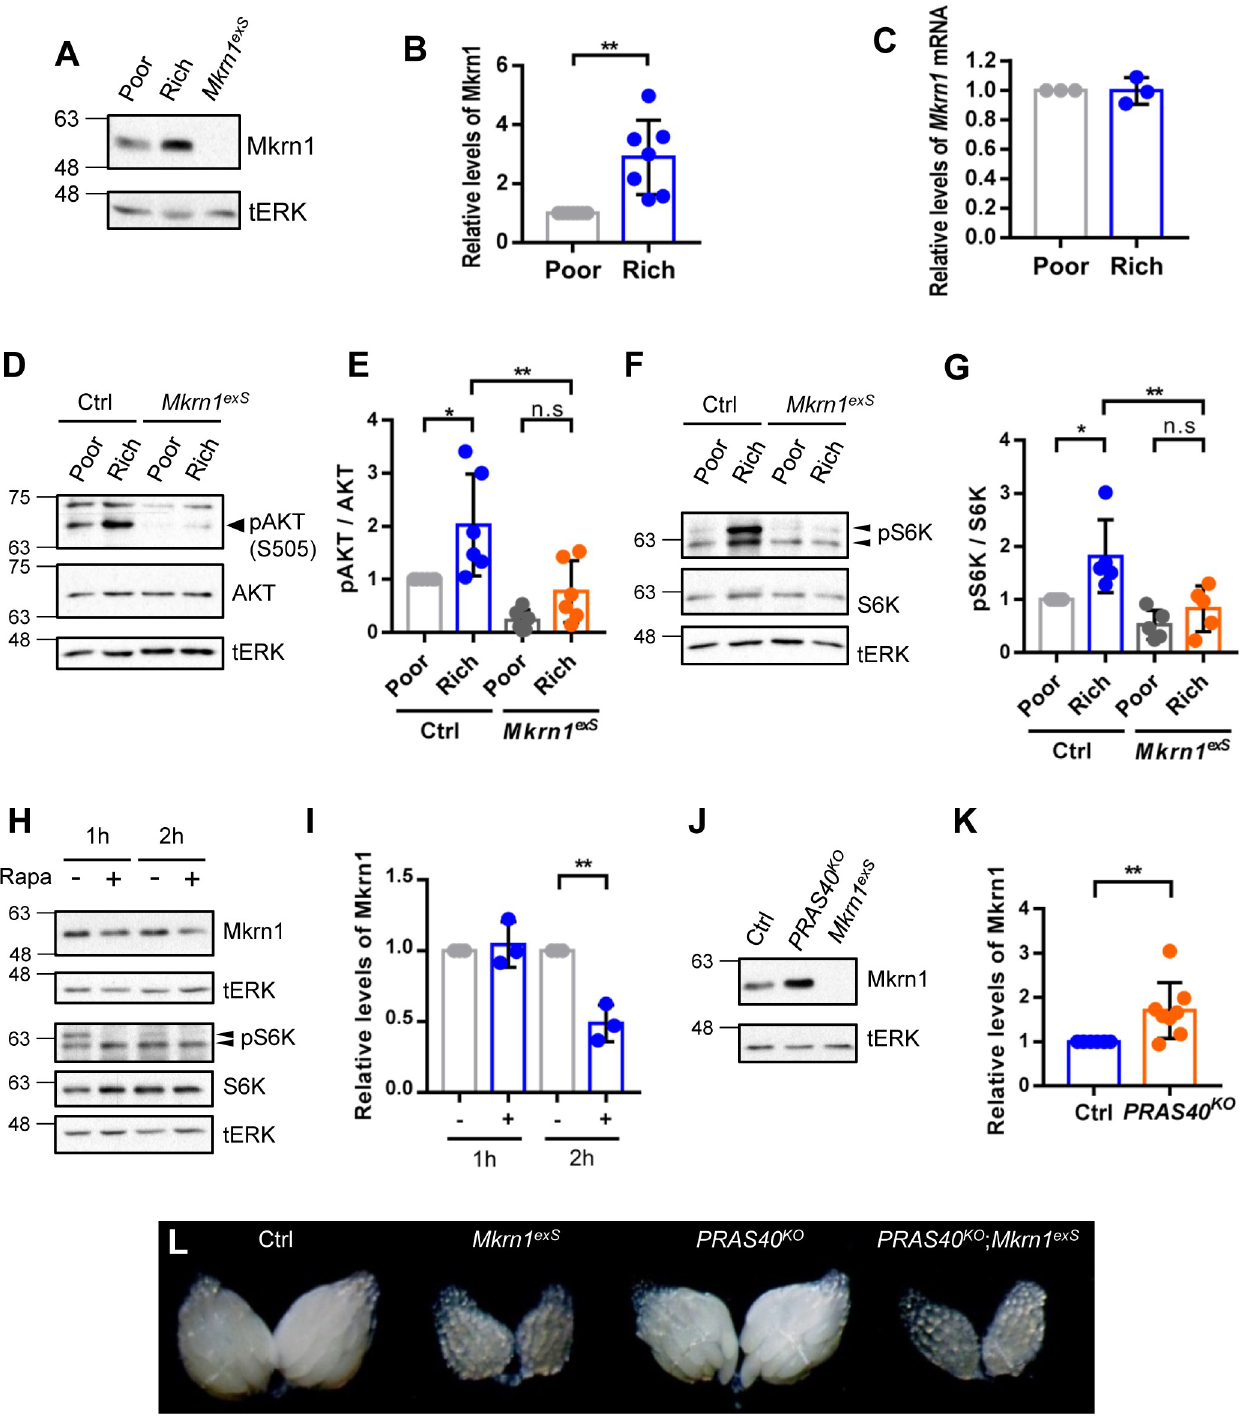
Fig 5. Mkrn1 ovarian protein levels are regulated by nutritional status and TOR signaling in Drosophila. (A) Newborn female flies were reared for 24 hours under the indicated nutritional conditions. Protein extracts from flies under nutrient-poor or -rich conditions were subjected to immunoblot analysis using anti-Mkrn1 antibody, and tERK as the loading control. (B) Mkrn1 protein levels were quantified by measuring band intensities and the relative levels are shown. Error bars represent SEM from seven independent experiments. Asterisks indicate statistically significant differences (Student’s t-test: �� P < 0.0.01). (C) Ovaries from flies under the same nutrient conditions were used for mRNA extraction. Quantitative real-time PCR was performed to measure Mkrn1 mRNA levels and the relative levels are shown. Error bars represent SEM from three independent experiments. (D-G) Control and Mkrn1 exS